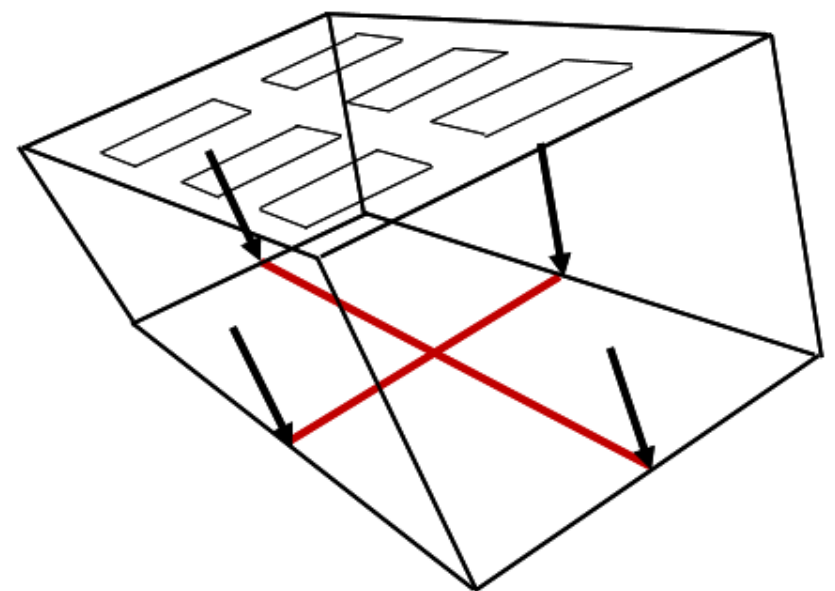
Figure 2. Illustrating the points UGR table was originally designed for (black arrows), and points for which the UGR table can be used (red lines).